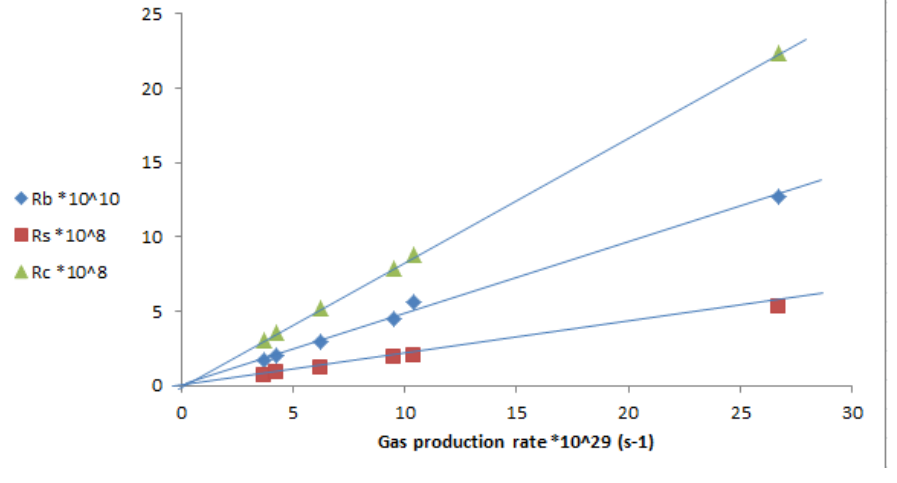
Figure 6: Bow shock R